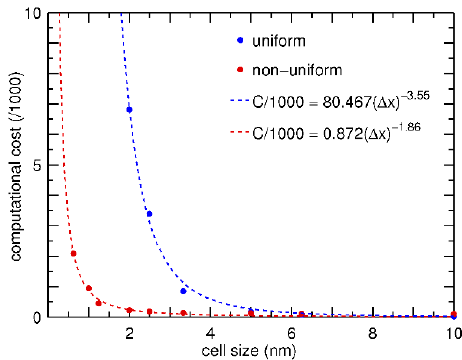
Figure 6. Computational cost C from the cases of uniform grids vs. cell size (blue dots) and the cases of non-uniform grids vs. central cell size (red dots), respectively, and the curve-fitting power functions for the cases of uniform grids (blue dashed curve) and the cases of non-uniform grids (red dashed curve), respectively.